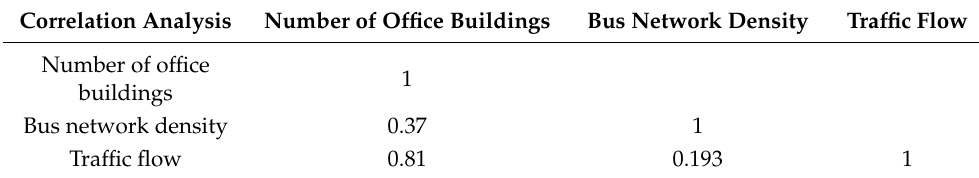
Table 6. Relevance analysis of internal mechanism of traffic corridor Eefect.